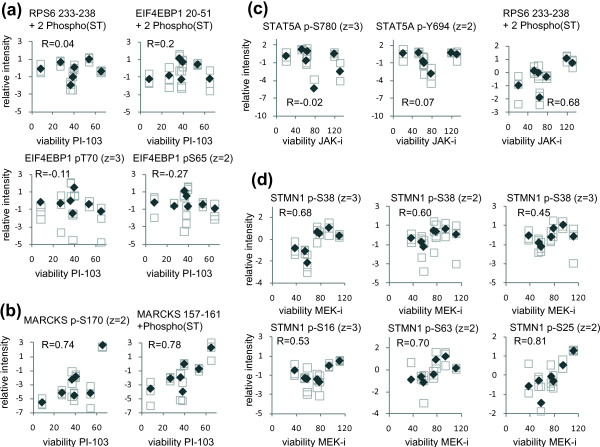
Correlation of known PI3K, JAK and MEK pathway markers with responses to kinase inhibitors. (a) Correlation of phosphorylated peptides containing phosphorylation sites known to be downstream of PI3K/mTOR with sensitivity to PI-103. (b) Correlation of phosphorylated peptides on MARCKS, known to contain sites phosphorylated by PKCs, with responses to PI-103. (c) Correlation of phosphorylation sites on STAT5A, a known JAK site, and ribosomal S6 (RPS6 gene product) with sensitivity to JAK-i. (d). Correlation of several sites on stathmin (STMN1 gene product) with the sensitivity to MEK-i. Open squares: individual data points; filled diamonds: averages of individual data points.